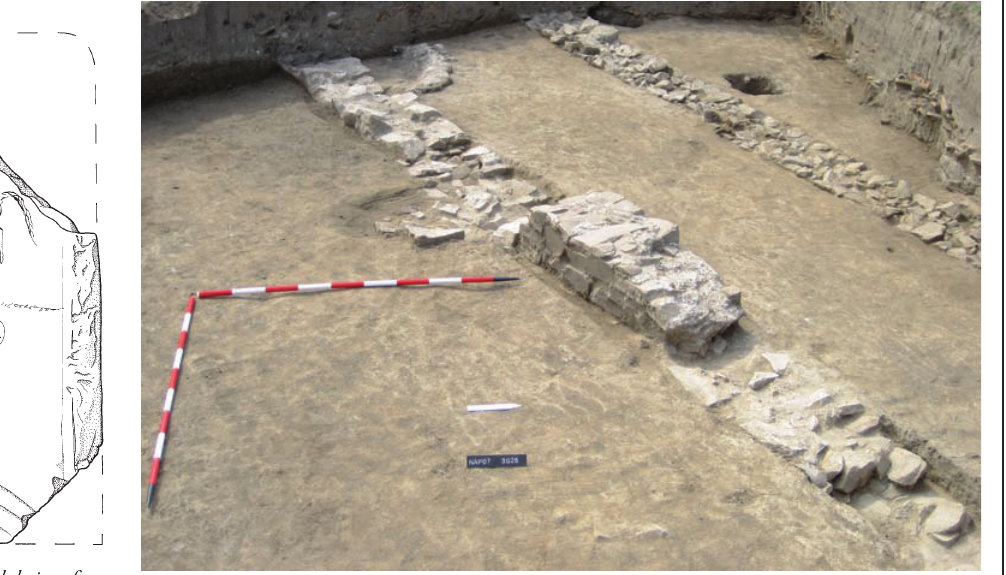
Figure 8 The roof tile with incised designs from Poşta (drawing by Frances Saxton) Figure 9 The probable granary at Po